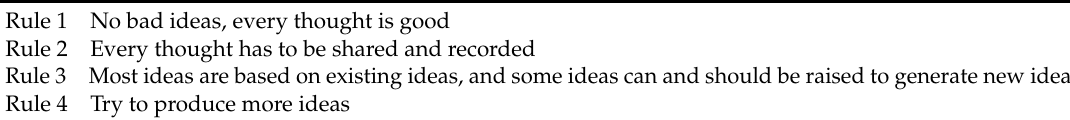
Table 1. Osborn’s Original Rules for Idea Generation in a Brainstorming